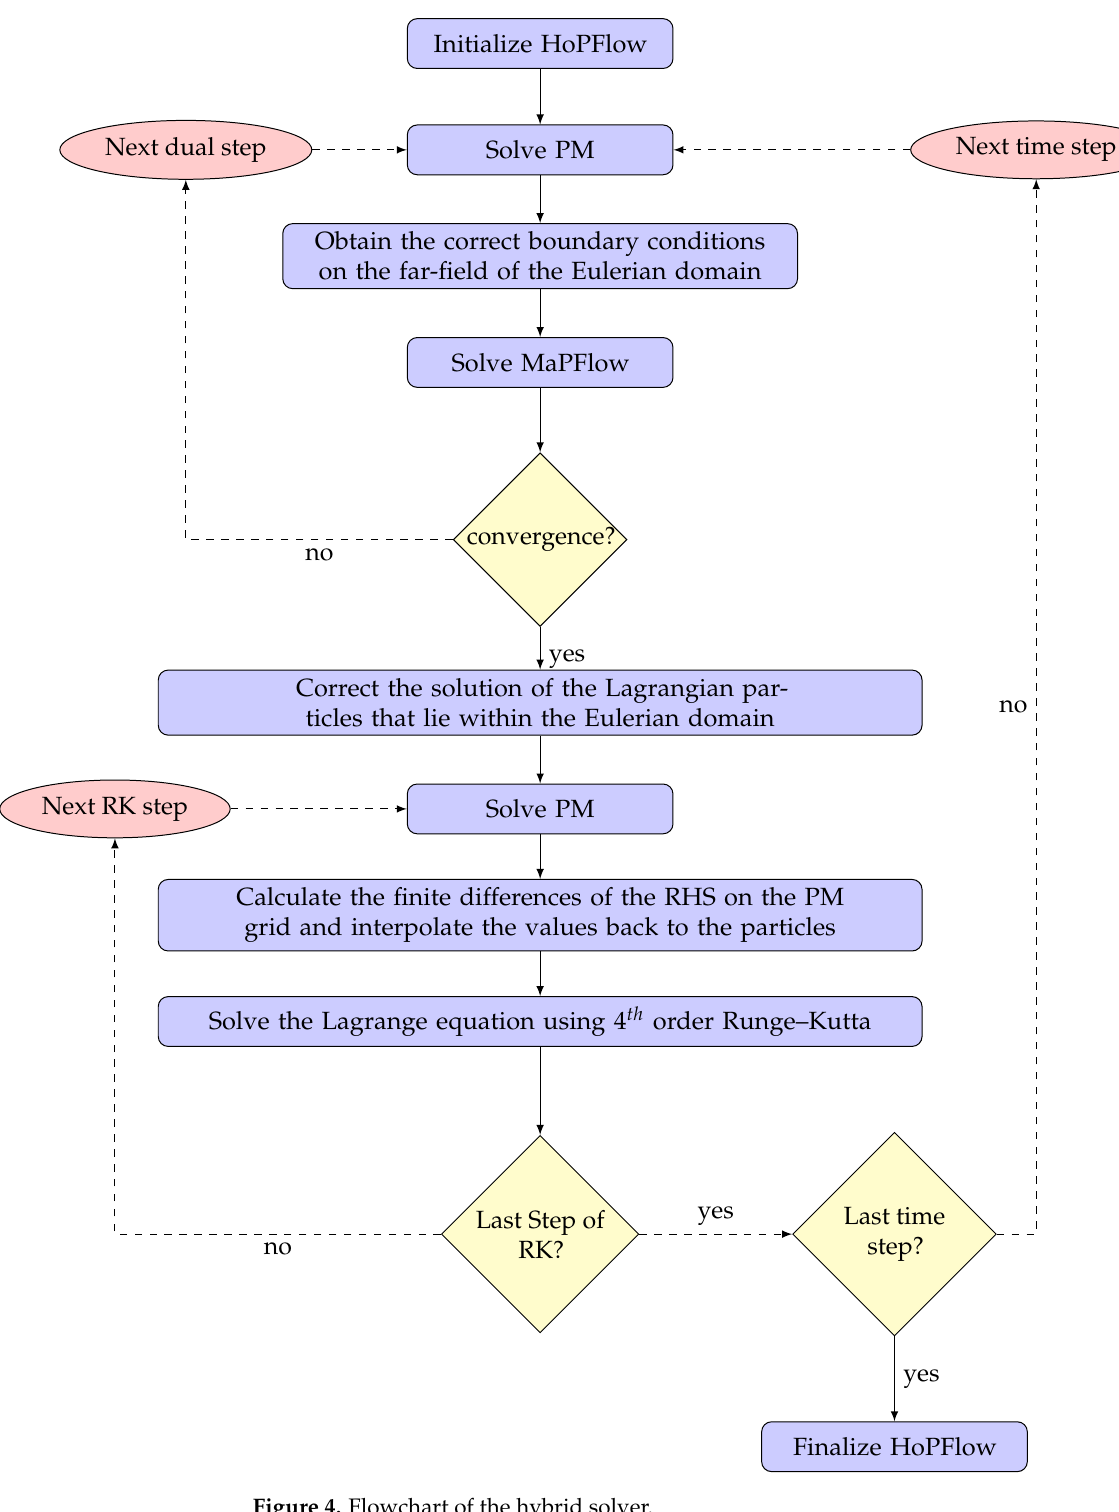
Figure 4. Flowchart of the hybrid